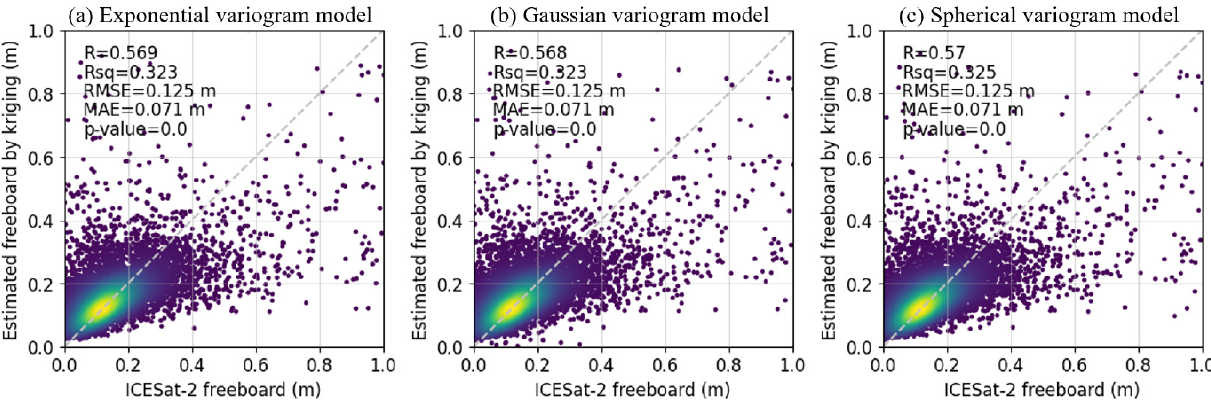
Figure 6. Scatter plot comparisons of the cross-validation for the three variogram models: ( a ) exponential, ( b ) Gaussian, and ( c ) spherical.